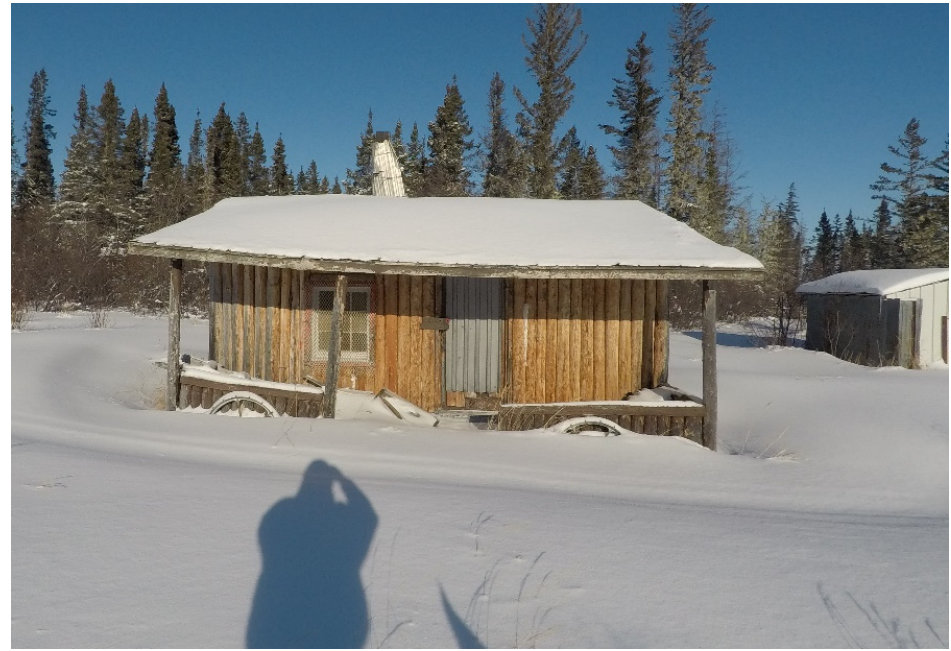
Figure 6. Youth participant taking a photo of a family camp.